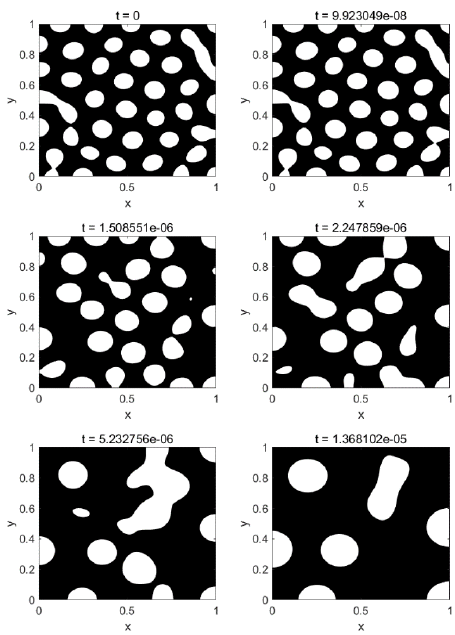
Figure 8. Dimensionless concentration spatial profiles c * ( x * , y * ) formed during the phase separation phenomena for the case where D = 10 5 , c o* = 0.3 and T * = 0.35. The asterisks were left out of the variables x , y , c , and t in the figure.